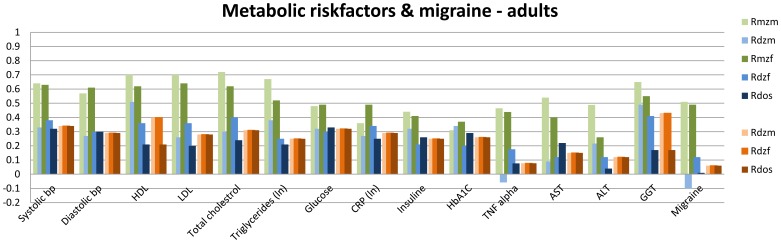
Twin correlations for Metabolic risk factors and Migraine.The green bars represent correlations in Monozygotic Male (MZM) twin pairs (light green) and Monozygotic Female (MZF) twin pairs. The blue bars represent correlations in Dizygotic Male (DZM) twin pairs, Dizygotic Female (DZF) twin pairs and Dizygotic Opposite Sex (DOS) twin pairs. The green and blue bars reflect the correlations in a full model, while the orange bars reflect twin correlations for Dizygotic (DZ) twin pairs in the most parsimonious model, with: DZM (light orange), MZF (normal orange), DOS (dark orange).